Question: Condense the content of this figure into a single sentence.
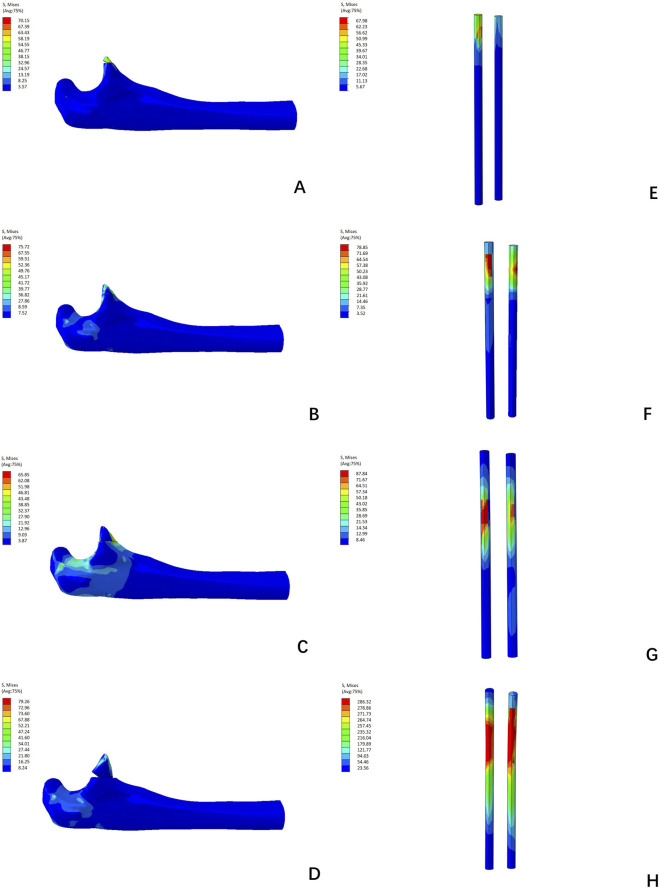
Answer: Von Mises stress distributions of the fracture fragments and K-wires in the pull-out simulation: (A) Von Mises stress distribution of the fracture fragment for the 15% fracture height model. (B) Von Mises stress distribution of the fracture fragment for the 30% fracture height model. (C) Von Mises stress distribution of the fracture fragment for the 45% fracture height model. (D) Von Mises stress distribution of the fracture fragment for the 60% fracture height model. (E) Von Mises stress distribution of K-wires for the 15% fracture height model. (F) Von Mises stress distribution of K-wires for the 30% fracture height model. (G) Von Mises stress distribution of K-wires for the 45% fracture height model. (H) Von Mises stress distribution of K-wires for the 60% fracture height model.